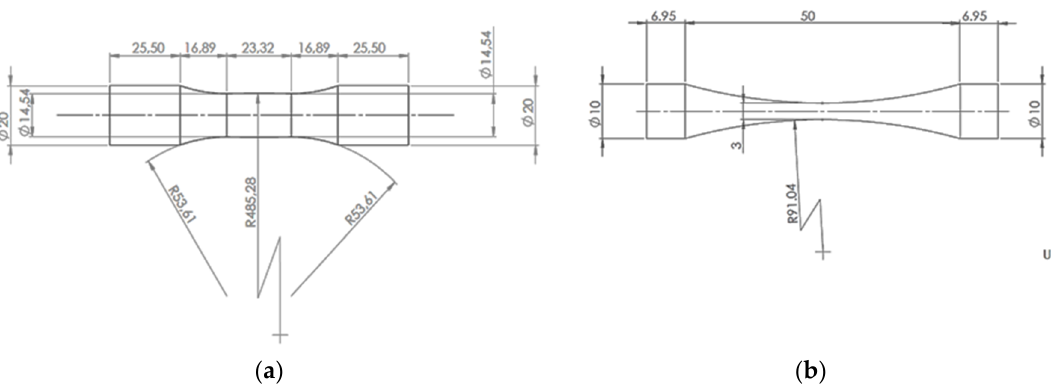
Figure 1. Geometry of the specimens subjected to ultrasonic tests: ( a ) Gaussian specimen; ( b ) hourglass specimen (not in scale, dimensions in mm).